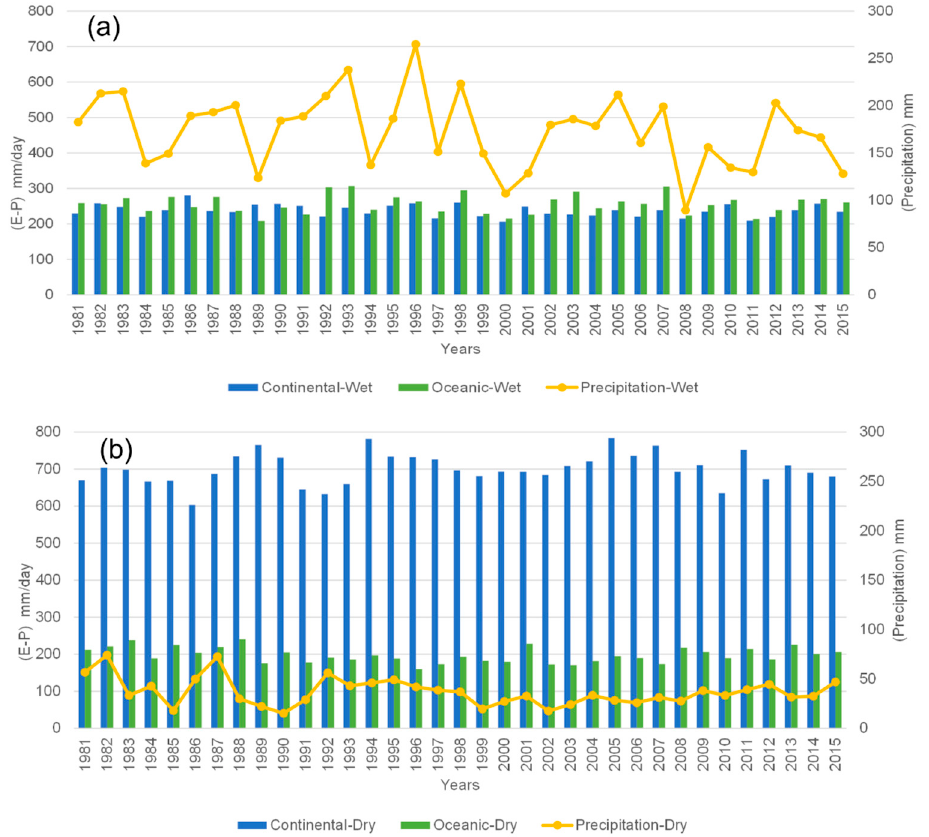
Figure 3. Oceanic and continental (E-P) > 0 (mm/day) values and precipitation amounts over Iran for the wet ( a ) and dry ( b ) seasons between 1981 and 2015.